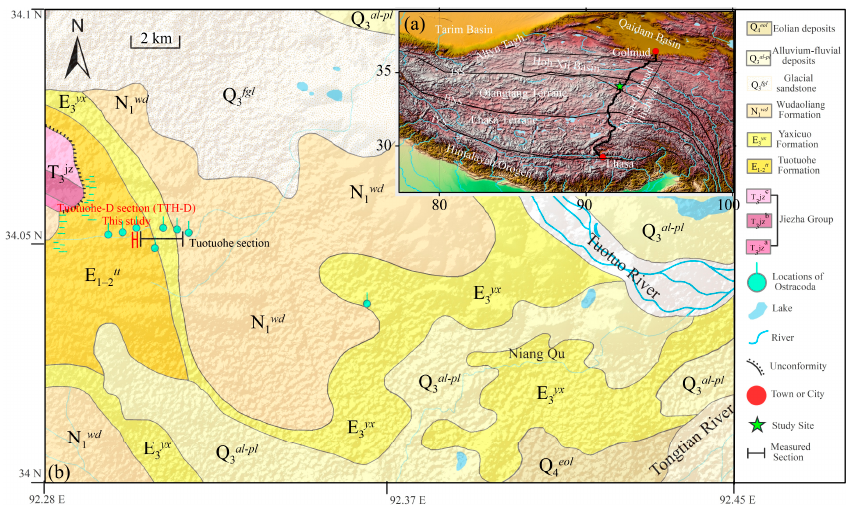
Figure 1. Major tectonic terranes and orogen of the Tibetan Plateau and geological map of the Tuotuohe Basin. ( a ) Topographic map of the Tibetan Plateau showing sutures, major terranes, the Lhasa-Golmud Highway, the Hoh Xil Basin, and the study site. ( b ) Geological map of the Tuotuohe Basin based on regional geological mapping [29]. The Tuotuohe section is from